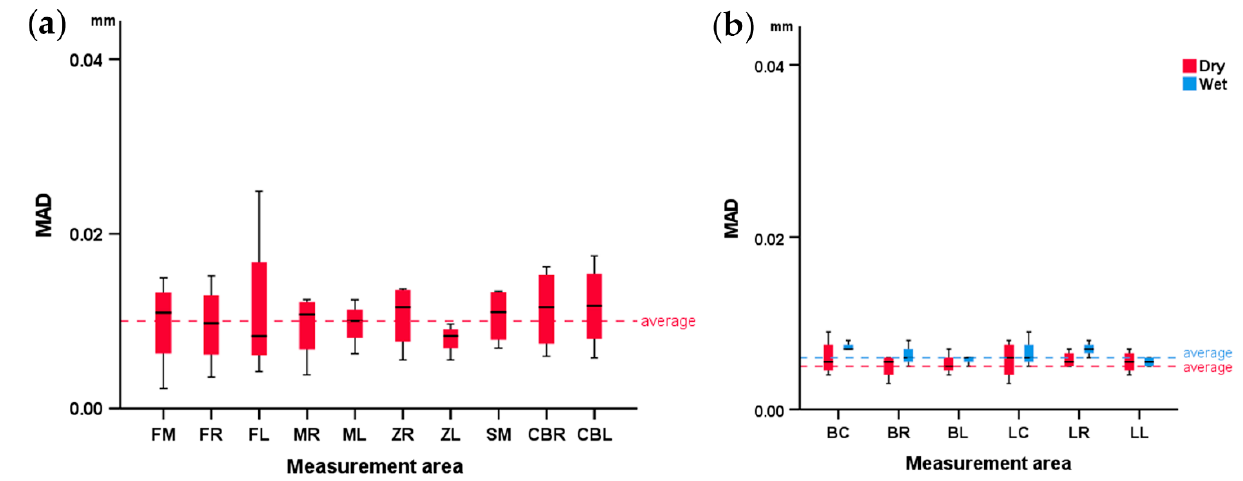
Figure 7. Box plots showing the software’s 3D model generation error at each measurement area in ( a ) dry conditions at the skulls and ( b ) dry and wet conditions at the mandibles. MAD: mean absolute distance. Skull: forehead left (FL), right (FR), and middle (FM), maxilla left (ML) and right (MR), zygomatic bone left (ZL) and right (ZR), anterior cranial base left (ACL) and right (ACR), and sphenoid bone middle (SM). Mandible: buccal left (BL), right (BR), and center (BC) and lingual left (LL), right (LR), and center (LC).